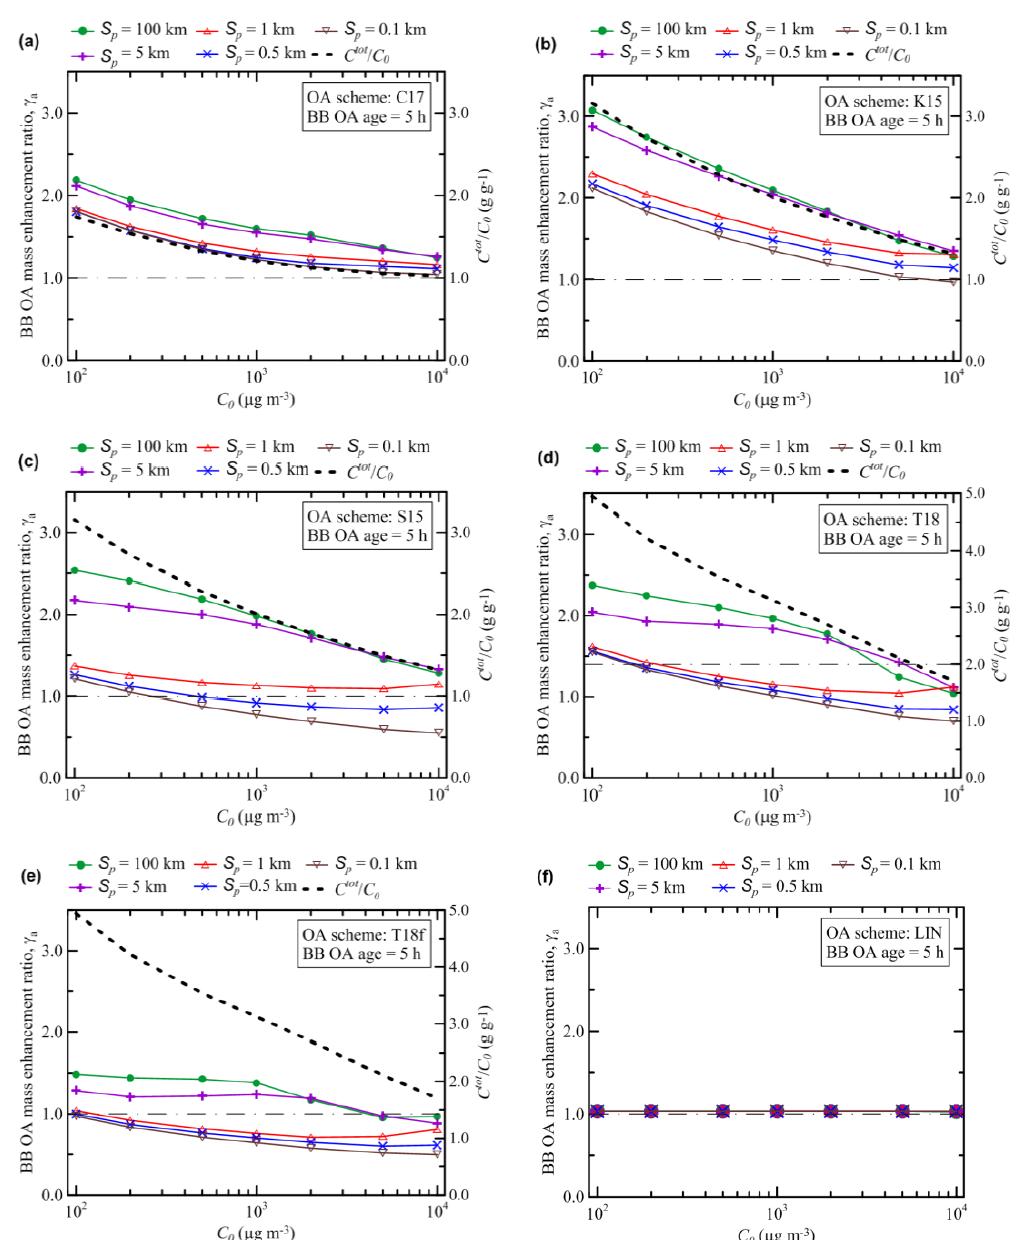
Figure 6. Simulated dependencies of the BB OA enhancement ratio after 5h of evolution on the initial BB OA mass concentration, C 0 . The dependencies are obtained with different OA schemes (Table 1) and with different values of the initial plume size, S p . Dashed lines show the ratio of the total initial mass concentration of SVOCs ( C tot ) to the initial BB OA concentration ( C 0 ) at thermodynamic equilibrium according to Eq. (18). A horizontal dashed–dotted line in each panel indicates the situation where no BB OA mass enhancement occurs ( γ a =